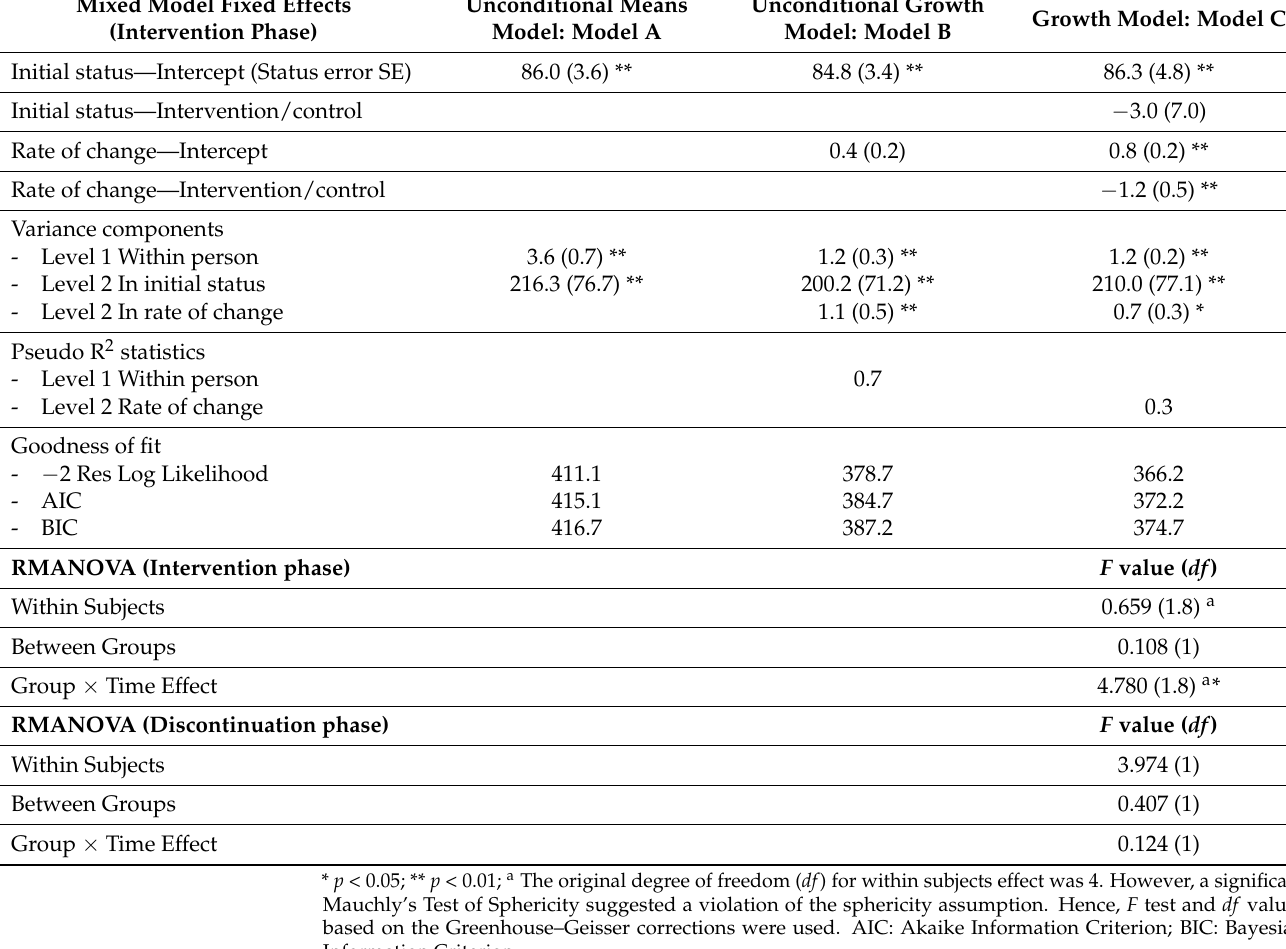
Table 4. Results of the mixed model analysis and